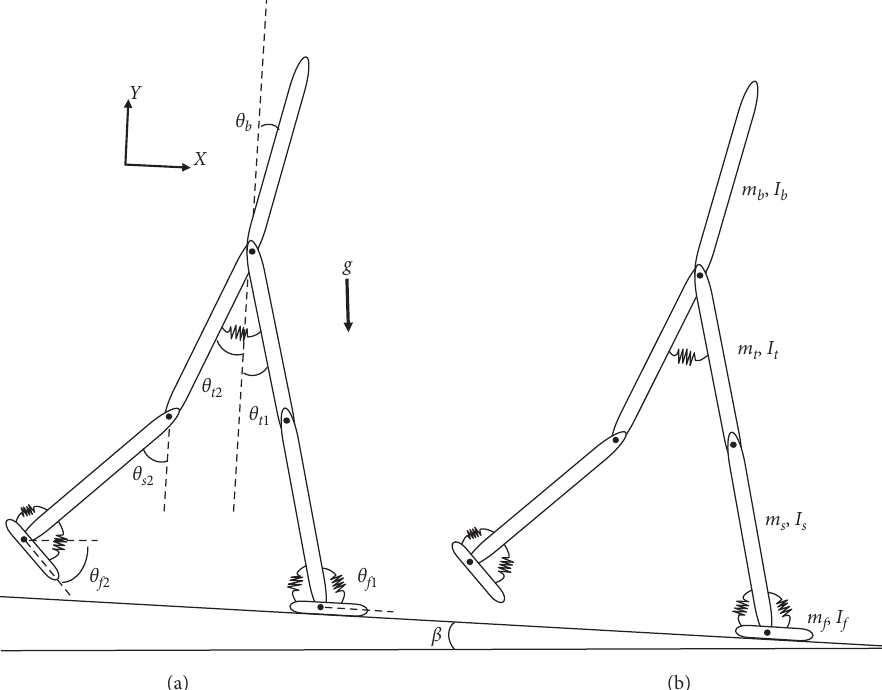
Figure 1: 7-link bipedal walking model: (a) the degree of freedom; (b) the mass distribution and the torsional spring of the